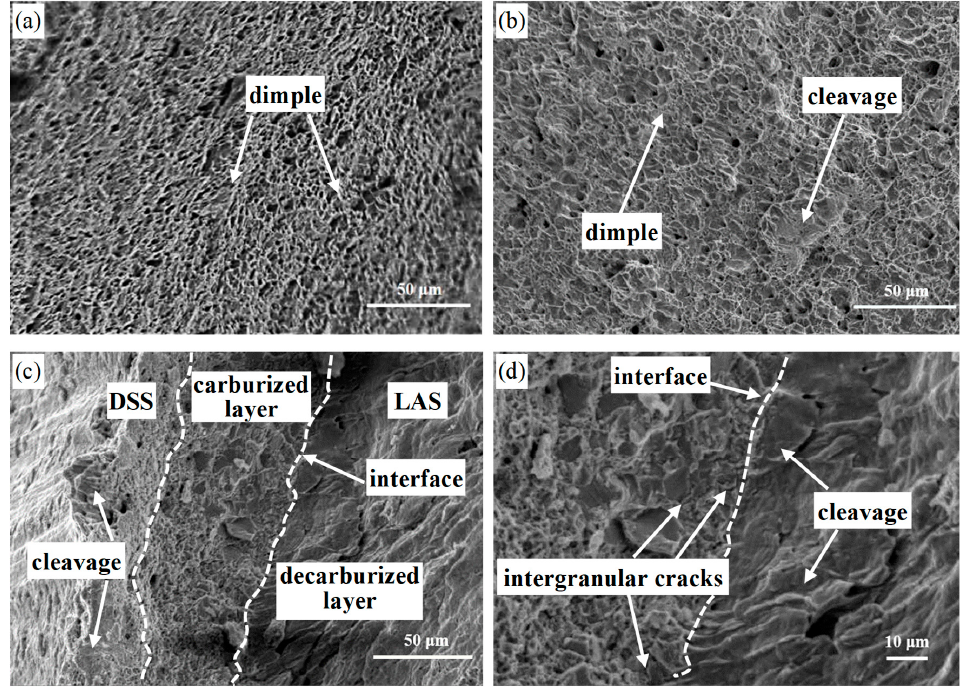
Figure 9. Fracture morphology of the DSS/LAS-clad rebar: ( a ) DSS cladding, ( b ) LAS core, ( c , d ) in- terface zone.